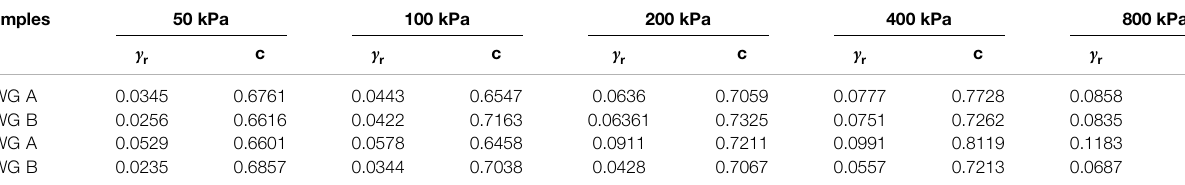
TABLE 6 | Fitting parameters of test data of samples with varying weathering degrees. Samples